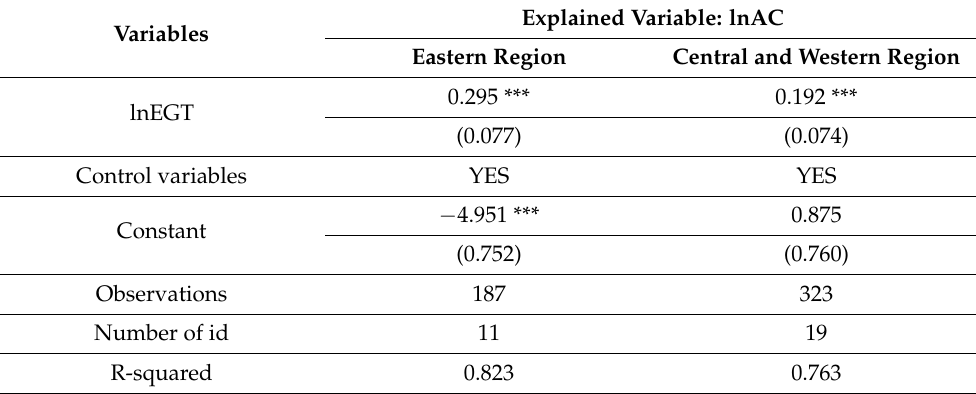
Table 4. Regression results of regional